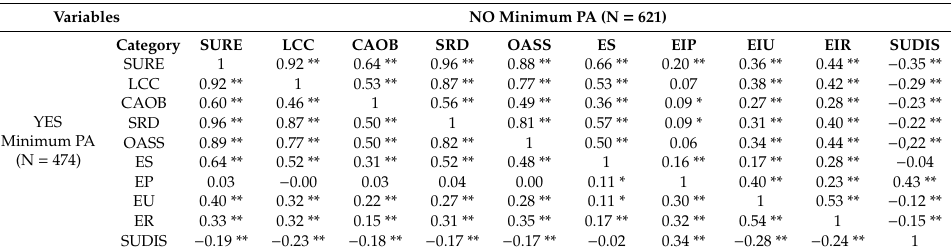
Table 3. Correlation between the dimensions of resilience, emotional intelligence, and psychological distress, as a function of physical activity engagement (beneficial physical activity, non-beneficial physical activity and